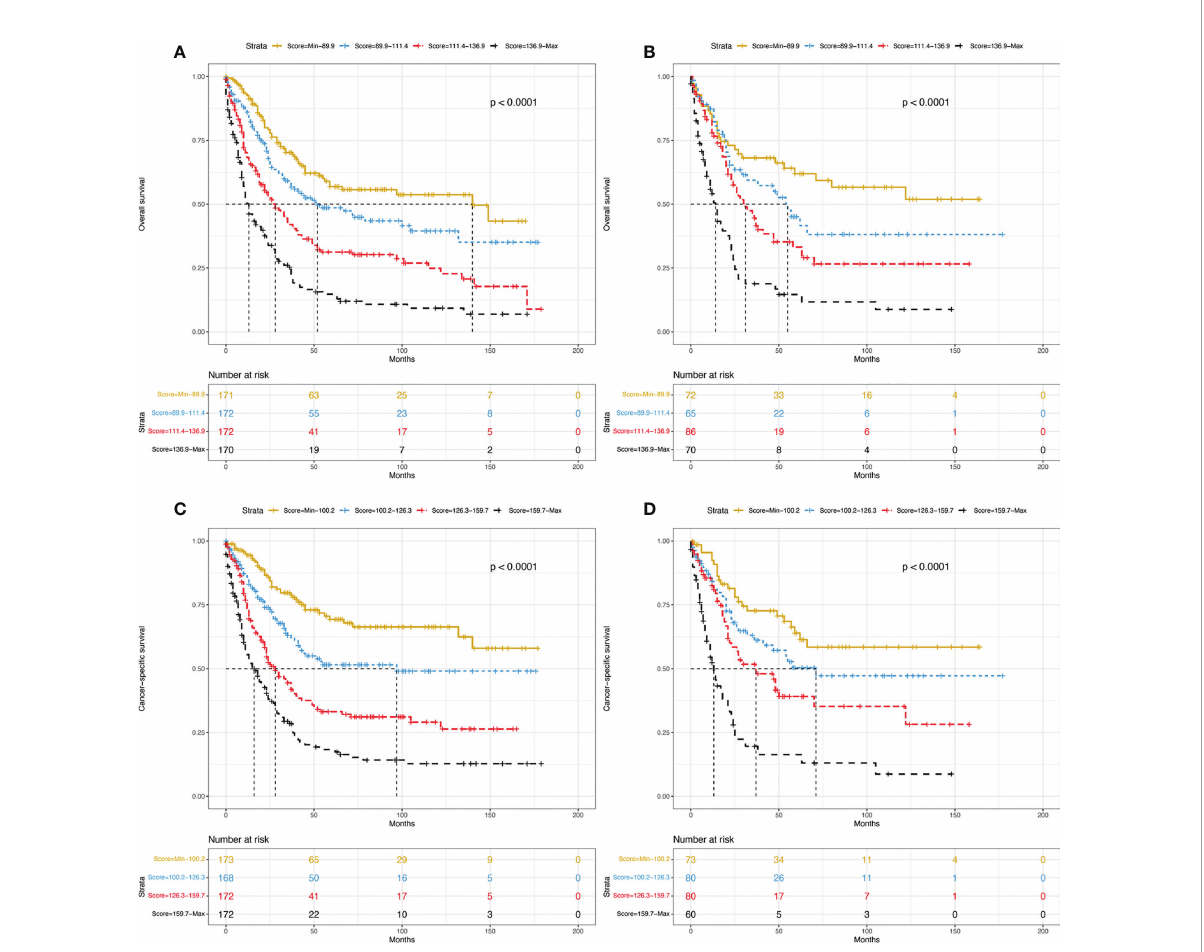
FIGURE 6 Kaplan – Meier curves of OS for the training group (A) and validation group (B) strati fi ed by different risk scores. Kaplan – Meier curves of CSS for the training group (C) and validation group (D) strati fi ed by different risk scores. OS, overall survival; CSS, cancer-speci fi c